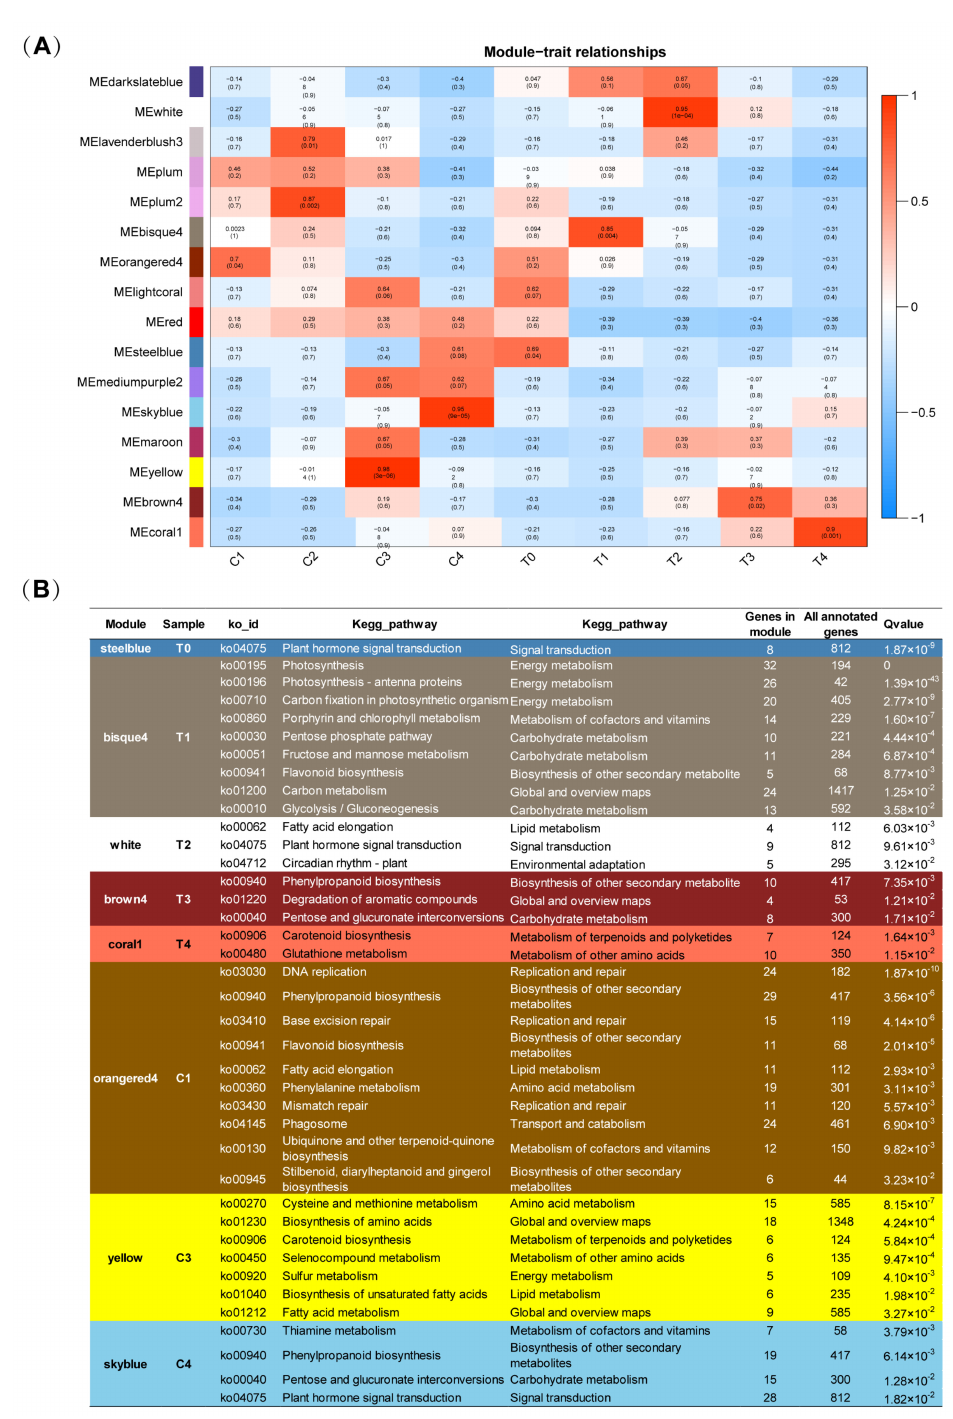
Figure 3. Weighted Gene Co-Expression Network Analysis (WGCNA) for differentially expressed genes in Narcissus flowers and KEGG enrichment analysis of sample-specific modules for different development periods of coronas and tepals. ( A ). WGCNA analysis for differentially expressed genes of Narcissus tazetta . Corresponding p -values of module-sample correlations are indicated in parenthesis. The panel on the left side shows the sixteen modules. The color scale on the right side shows module-trait correlation from − 1 (blue) to 1 (red). ( B ). KEGG enrichment analysis of sample-specific modules for different development stages of tepals and